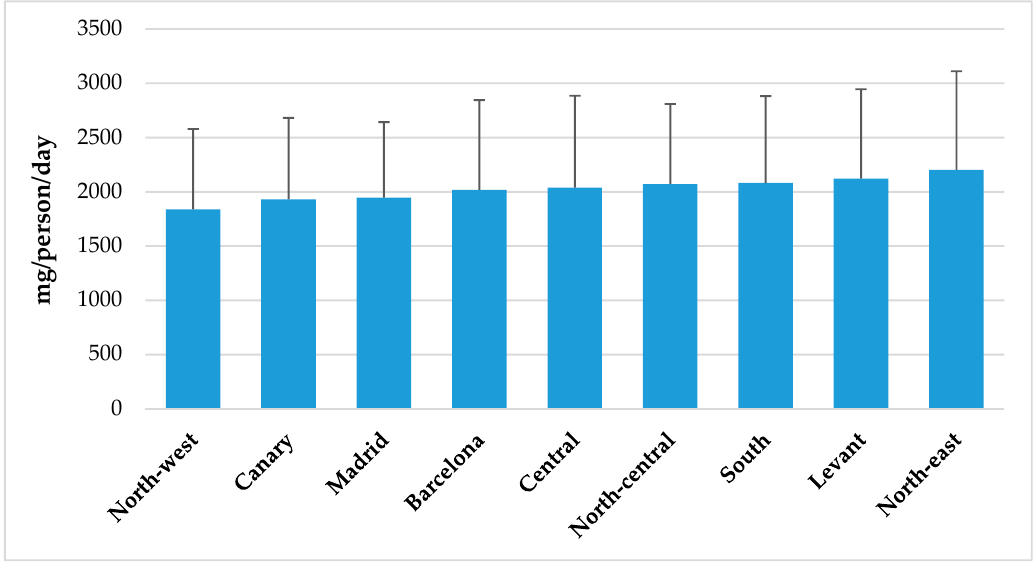
Figure 2. Sodium intake from total population segmented by Spanish Nielsen areas from the ANIBES study population .